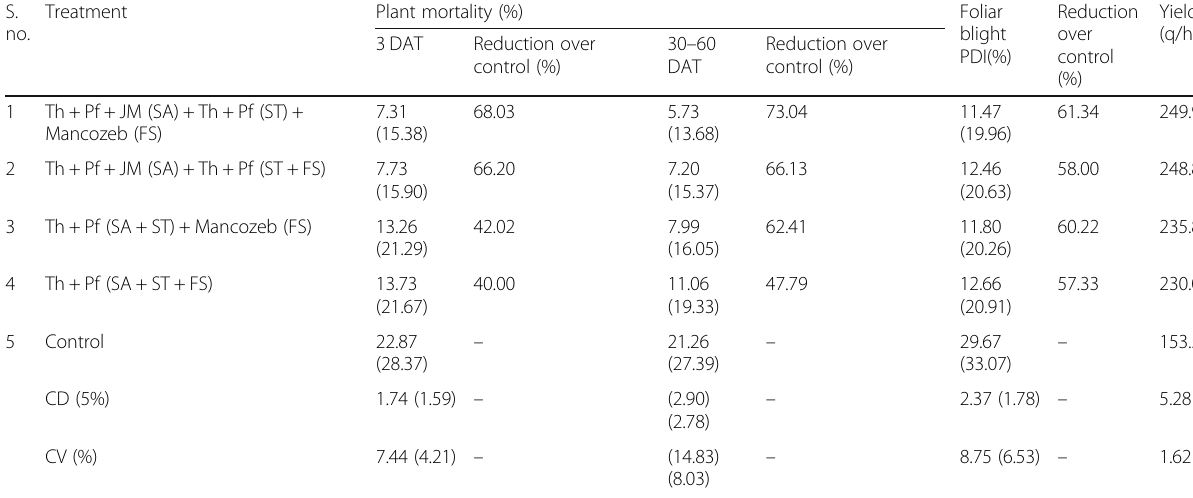
Table 5 Effect of selected treatments against tomato diseases and yield at five farmers ’ fields in village Davellamella in